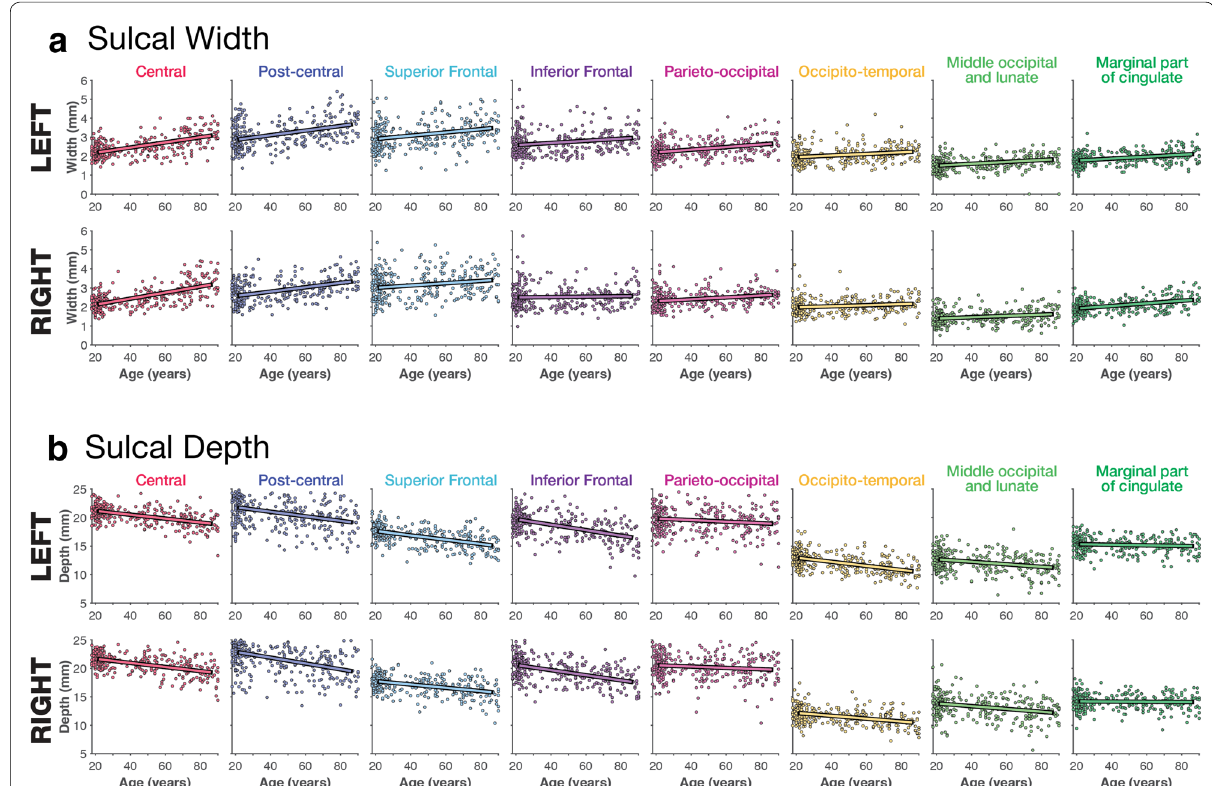
Fig. 5 Relationship between a sulcal depth and b width for each of the sulci examined, based on the OASIS